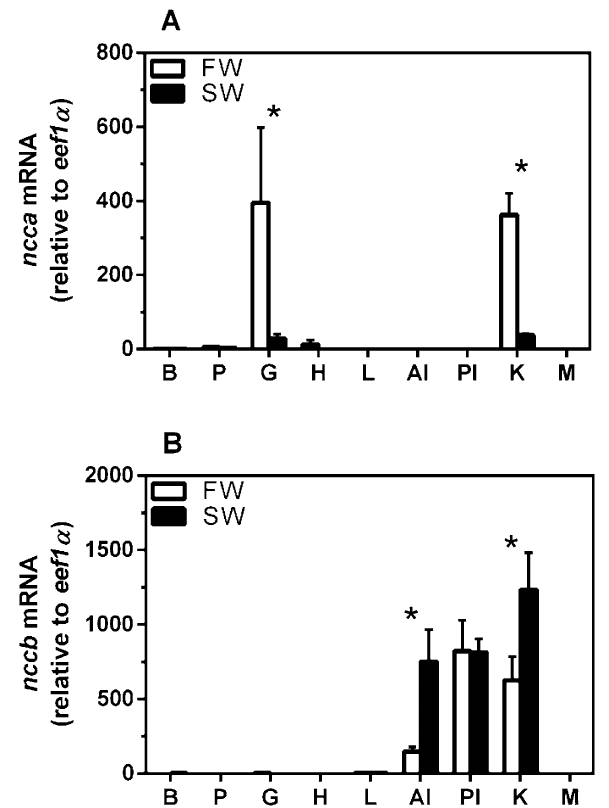
Figure 2. Gene expression of ncca ( A ) and nccb ( B ) isoforms in a tissue profile of juvenile sea lamprey acclimated to either FW or SW. Abbreviations: B, brain; P, pituitary; G, gill; H, heart; L, liver; AI, anterior intestine; PI, posterior intestine; K, kidney; M; muscle. Values are relative to the FW brain tissue. Each column represents mean ± SEM (n = 3). *Significant differences within a given tissue between environmental salinities (two-way ANOVA, Tukey’s post